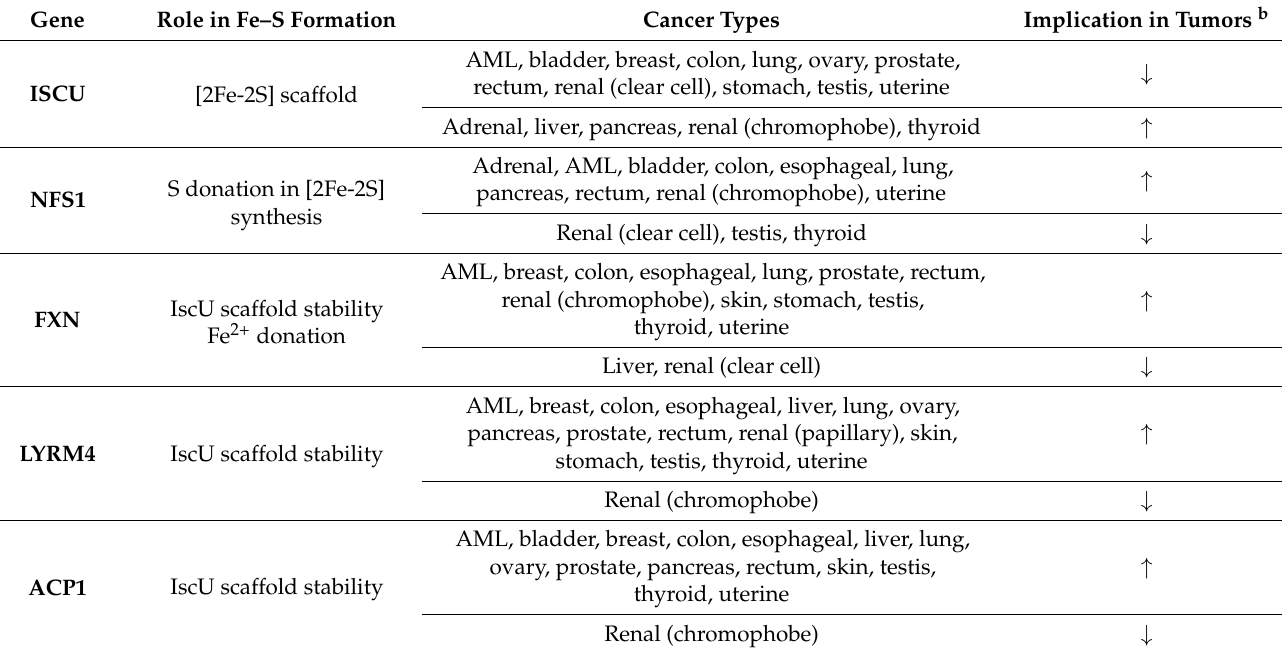
Table 1. [2Fe-2S] biogenesis in tumor tissues relative to their normal tissue counterparts a . Gene Role in Fe–S